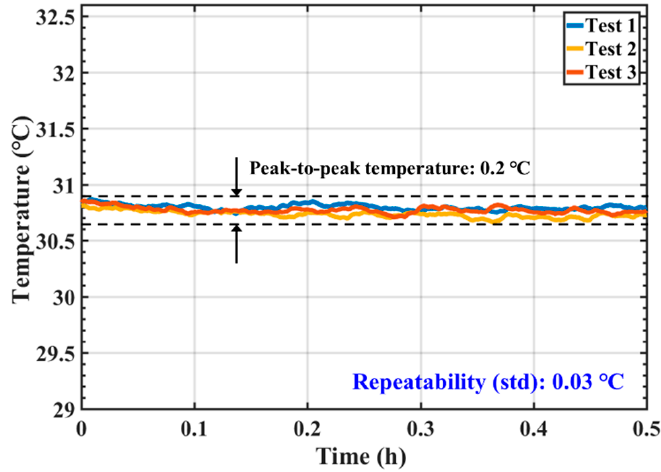
Figure 8. Repeatability study results for the same temperature sensor Chip E-1.